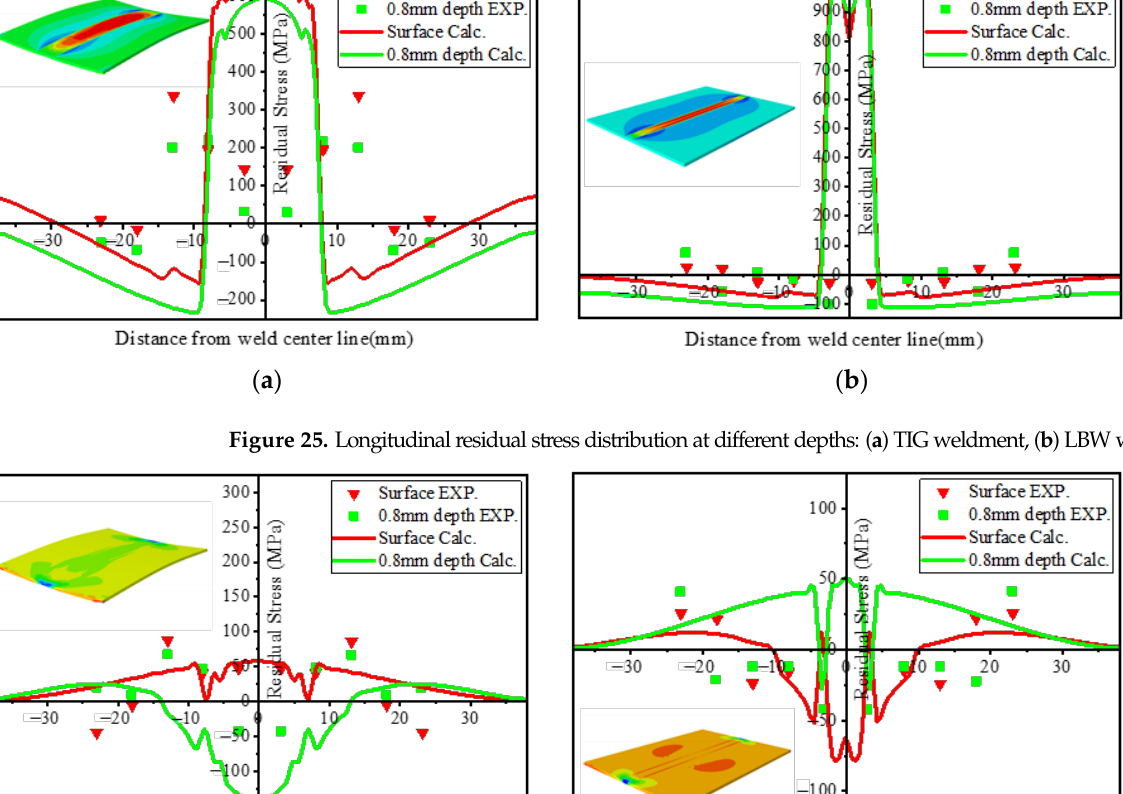
Materials 2022 , 15 , x FOR PEER REVIEW 25 of 29 in the volume shrinkage of the zone and the volume expansion of the FZ due to the gen- eration of a large amount of α′ martensite phase. These compressive stresses reduce the effect of tensile stress caused by thermal strain near the weld center. ( a ) ( b ) Figure 25. Longitudinal residual stress distribution at different depths: ( a ) TIG weldment, ( b ) LBW